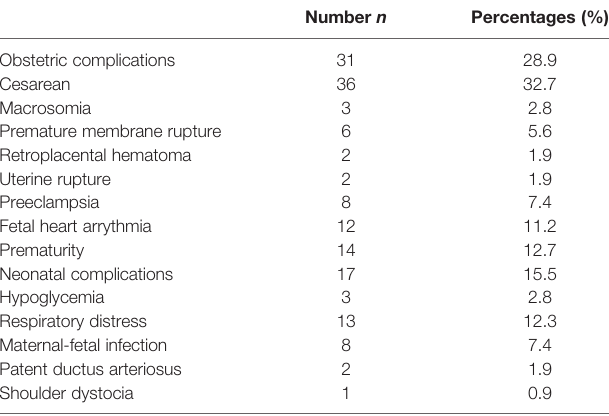
TABLE 1 | Medical and social criteria. TABLE 2 | Obstetrical and neonatal